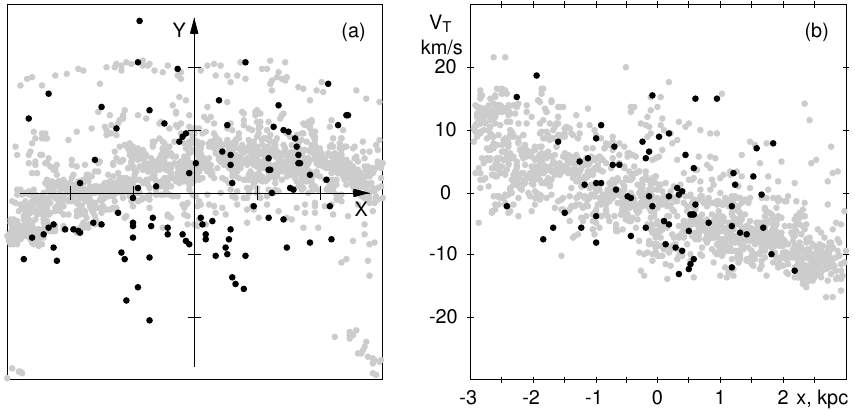
Fig. 2. Cepheids (black circles) and model particles (gray circles) with negative radial residual velocities ( V R < 0). These objects are supposed to belong to the descending segment of the outer ring R 2 . (a) Their distribution in the Galactic plane, with the X - axis pointing in the direction of the Galactic rotation, the Y -axis directed away from the Galactic center and the origin at the Sun’s position. One tick interval along the X - and Y -axis corresponds to 1 kpc. We can see that Cepheids fall nicely along the fragment of a leading spiral. (b) Dependence of azimuthal velocity V T on coordinate x . Both Cepheids and model particles demonstrate a decrease in V T with increasing x